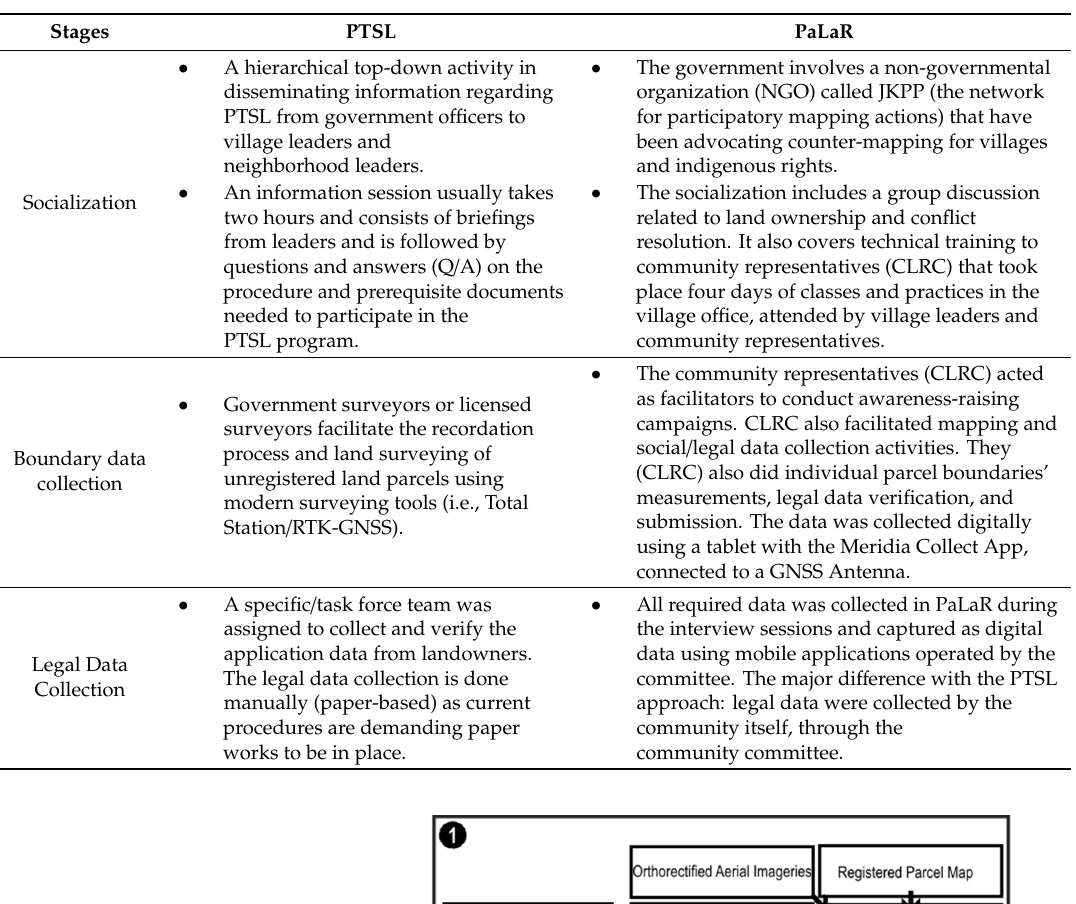
Table 1. Di ff erences between the Pendaftaran Tanah Sistematik Lengkap (PTSL) and the participatory land registration (PaLaR) implementation.